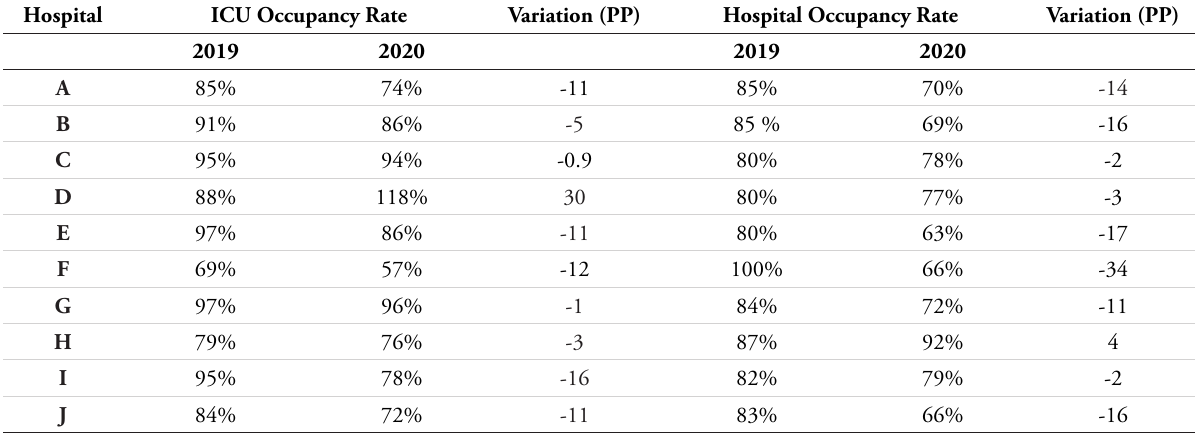
Table 2: Hospital Occupancy Rate Variation from 2019 to